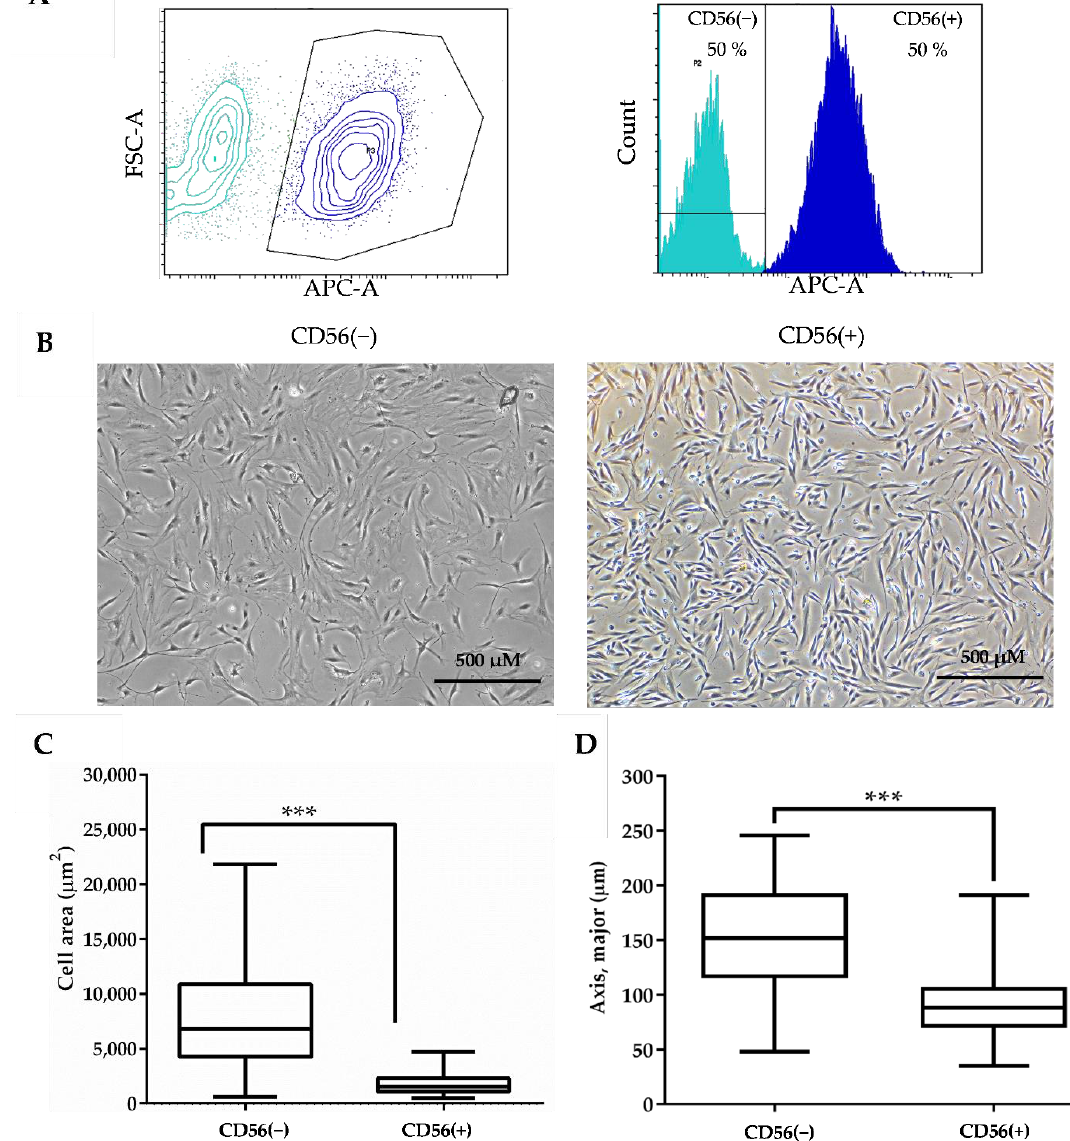
Figure 4. Sorting and morphology analysis of CD56( − ) and CD56(+) subpopulations. ( A ) Identi- fication of CD56( − ) and CD56(+) subpopulations with BD FACSAria™ flow cytometer. ( B ) Light microscope micrographs of CD56( − ) and CD56(+) SM-MSC subpopulations. The evaluation of CD56( − ) and CD56(+) cell size according to the cell attachment area ( C ) and longitudinal axis ( D ). Data are shown as mean ± standard deviation (SD). Data are significant at *** p ≤ 0.001 level, n = 100 from three light microscope micrographs of each cell type. Student’s t -test was calculated by the Graphpad Prism 6